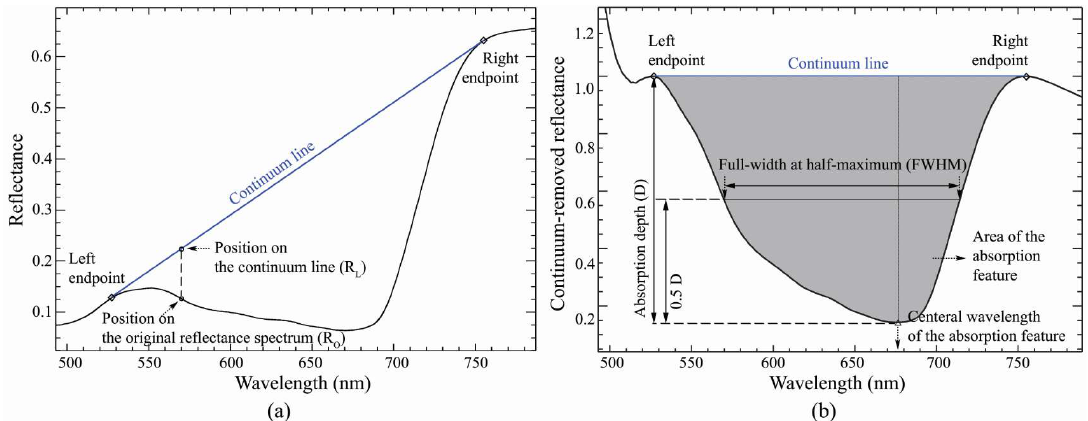
Figure 2. Spectral absorption features in the range from 500 nm to 800 nm: ( a ) Continuum endpoints (diamonds) and continuum line (blue line), and ( b ) continuum-removed features describing the absorption depth, the full-width of feature at half-maximum absorption depth, wavelength position of the center of the feature (triangle), and area of the feature (grey-filled region).